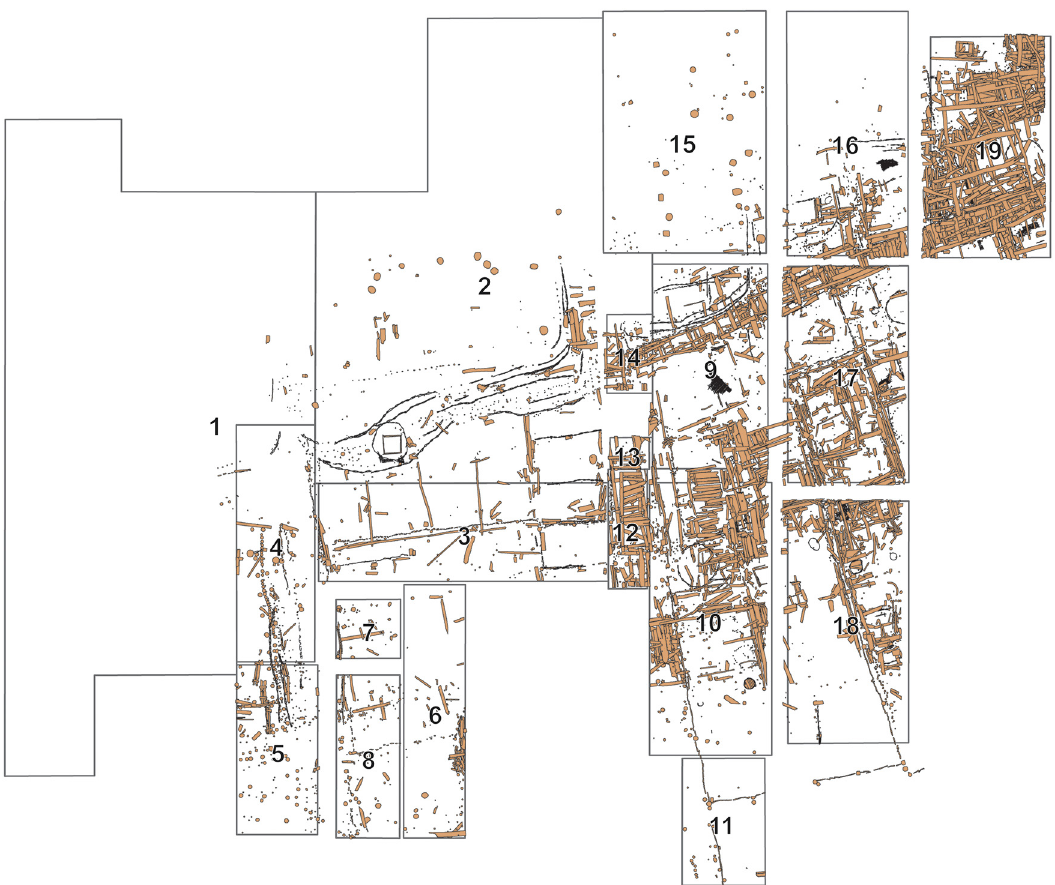
Figure 9: After completion of step 11: all 9018 digitized wooden features on display in the 19 trenches of the Plessenstraße 83/3 excavation ( Graphics: F. Rösch )